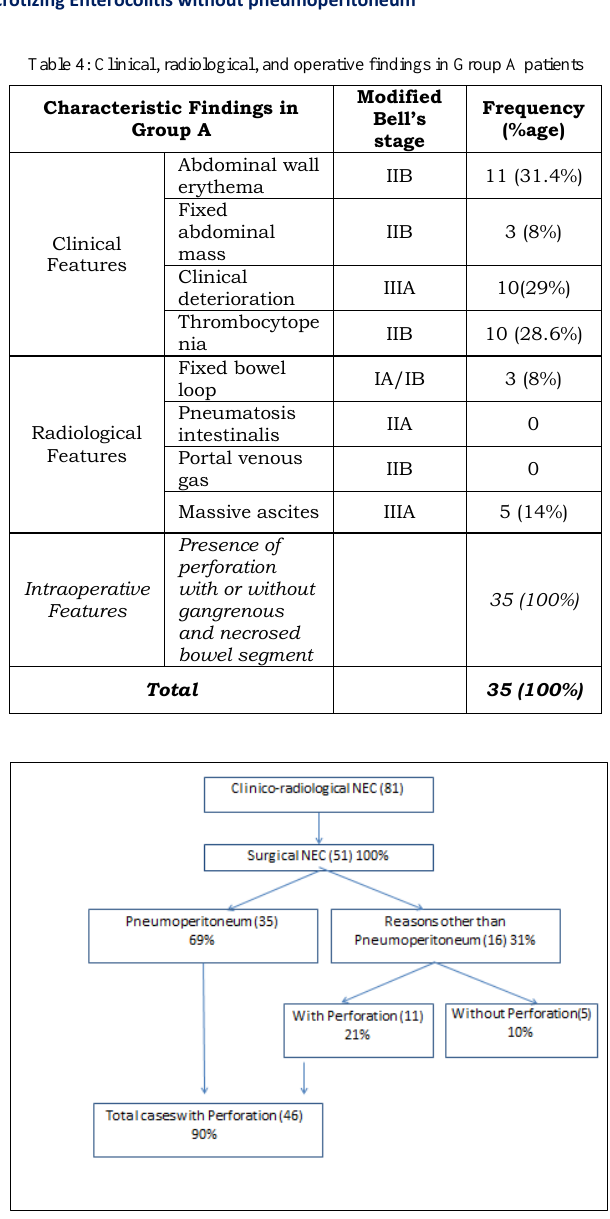
Figure 1: Indications for surgery in newborn with necrotizing enterocolitis (NEC). The absolute frequency is presented in parentheses A comparative study was done between both groups [Table 5]. Group B patients had a longer duration